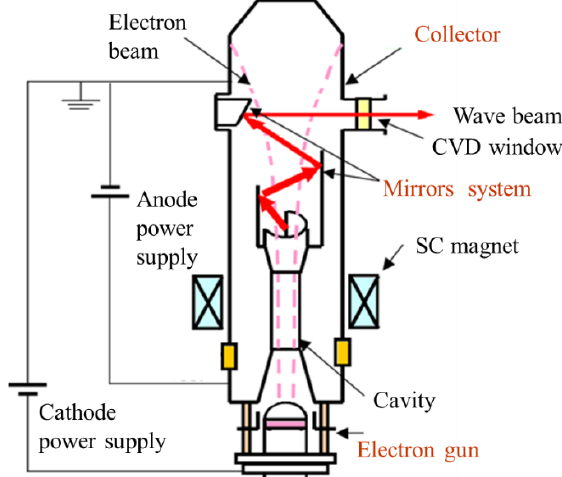
Fig. 21. The composition of the gyrotron, where the parts marked in red fonts are parts that need to be